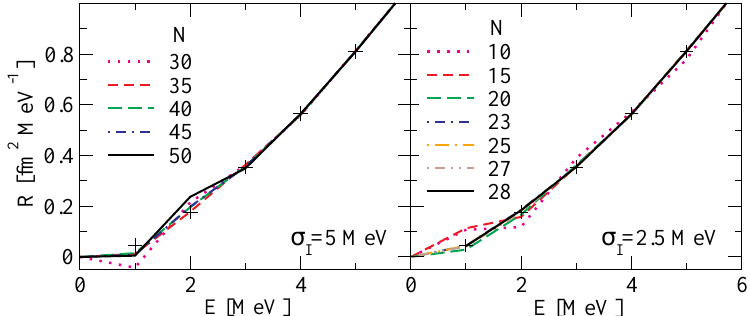
= 5 MeV) with various numbers N of Figure 5: Left panel: Inversions of L ( σ , σ R I basis functions for the inversion (see Eqs. (7), (8)); right panel: inversions as in left = 2.5 MeV). Plus signs describe exact panel but for L ( σ , σ R I